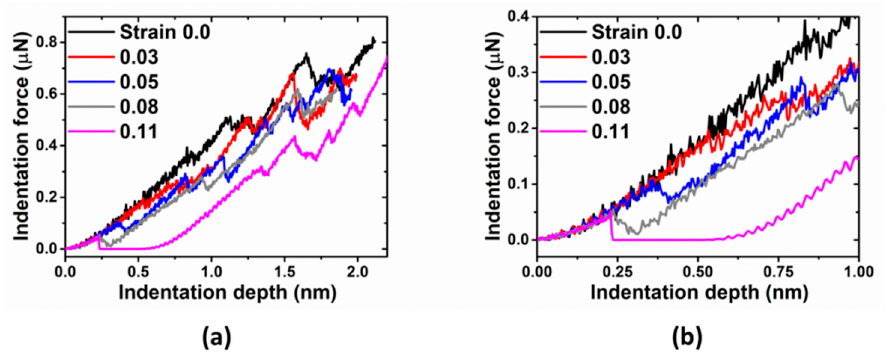
Figure 5. ( a ) Indentation force vs. indentation depth for Cu with elastic deformation, indented with tip radius R = 7.5 nm. ( b ) Indentation force in early stage of indentation.